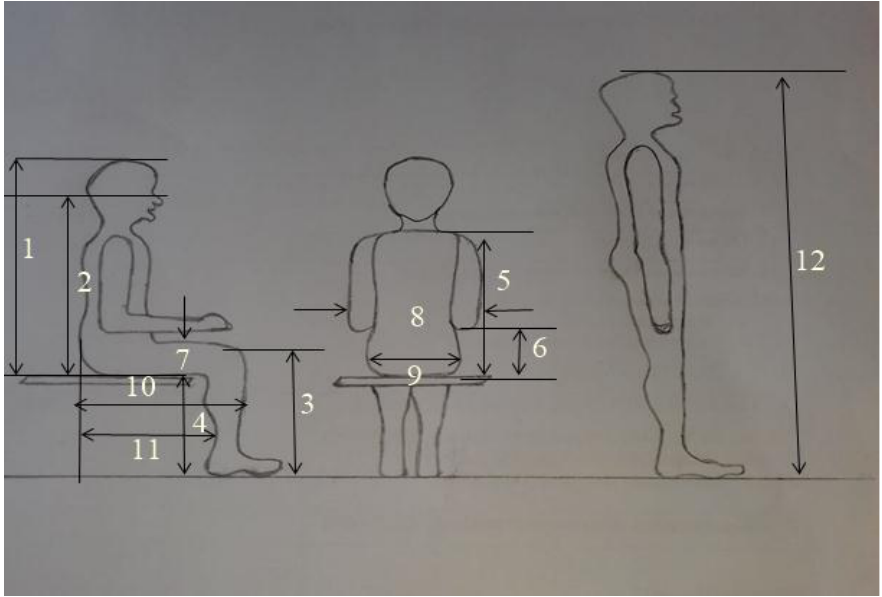
Figure 1. Anthropometric data required in classroom furniture